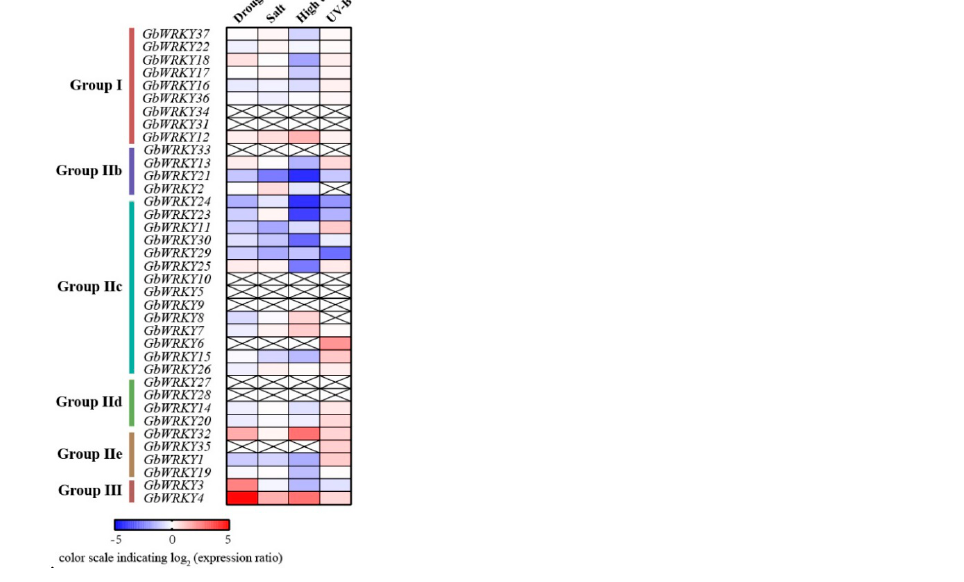
Figure 6. Analysis of expression patterns of GbWRKY genes under drought, salt, high temperature and UV − B radiation. The data were obtained from the publicly dataset. In the cDNA library of leaves under stress treatment, q-value < 0.05 and log2|fold − change| > 1 were used as the criteria to screen the differentially expressed WRKY genes.